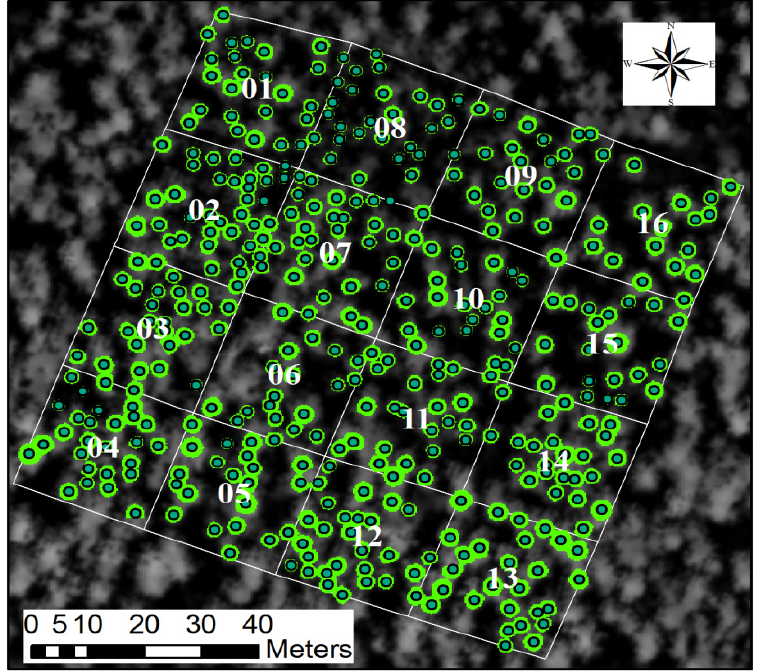
Figure 3. The spatial distribution of 402 tree crowns in 16 sub-sample plots nested in a permanent sample plot.